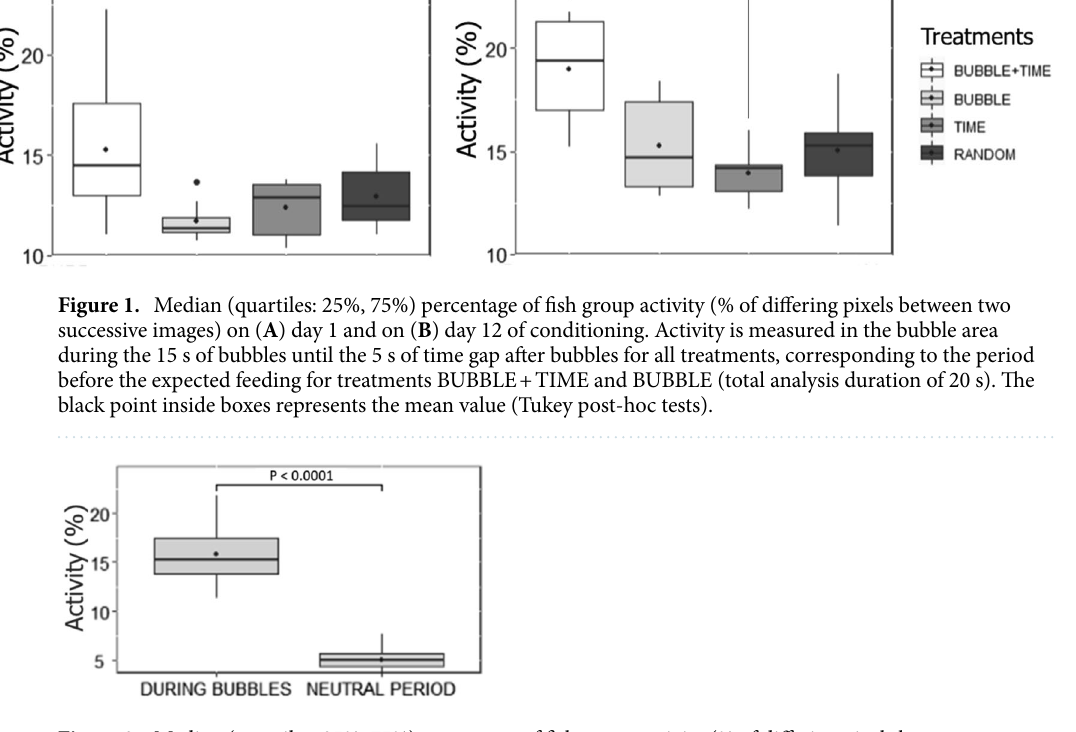
Figure 2. Median (quartiles: 25%, 75%) percentage of fish group activity (% of differing pixels between two successive images) in the bubble area on the day 12 of conditioning. “During bubbles” represents the 15 s of bubble diffusion + 5 s of time gap for all treatments. “Neutral period” represents 6-min periods with no feed delivery or bubble diffusion. The black point inside boxes represents the mean value (Tukey post-hoc test).